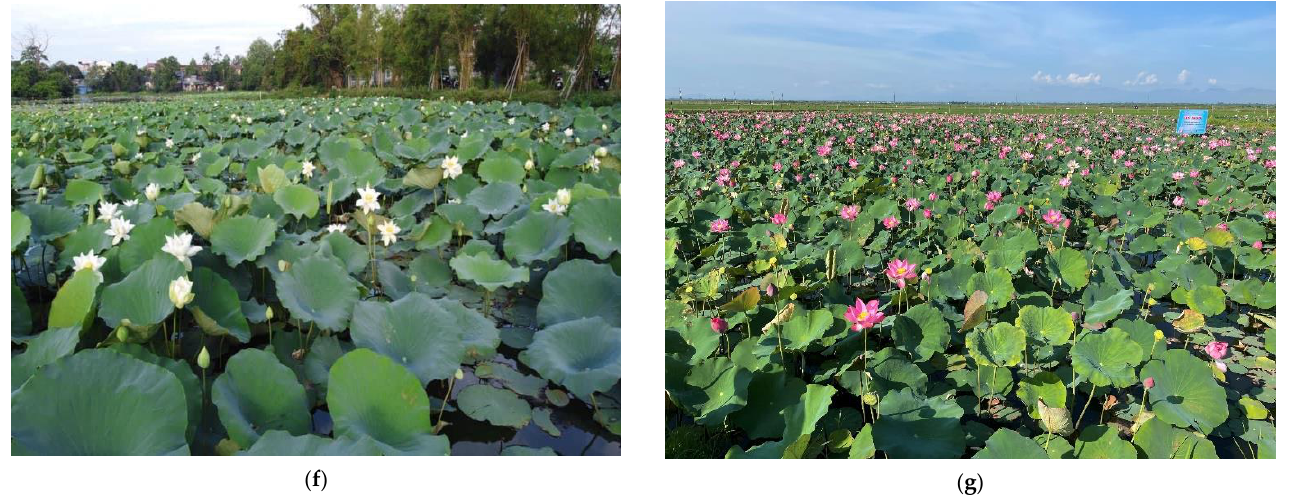
Figure 1. Study site with ground truth points (GTPs). The red rectangles indicate the location of Thua Thien Hue province in Vietnam ( a ), Phong Dien district in the boundary of Thua Thien Hue province ( b ), and the study site ( c ). Sentinel-1 ( d ) and Sentinel-2 ( e ) scenes used in the study. Field images (taken by K.P.L and N.T.H) of growing lotus ( f , g ).